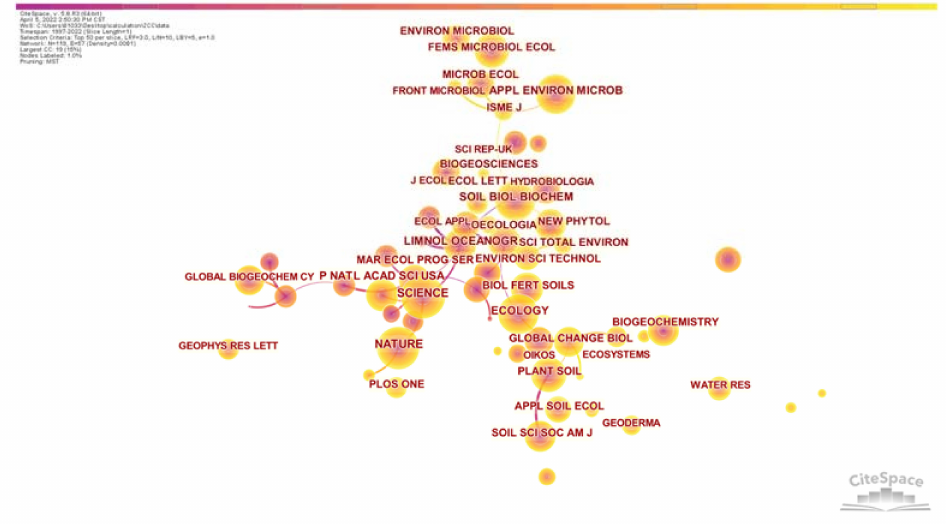
Figure 3. Knowledge map of co-journals of papers published on ZCC from